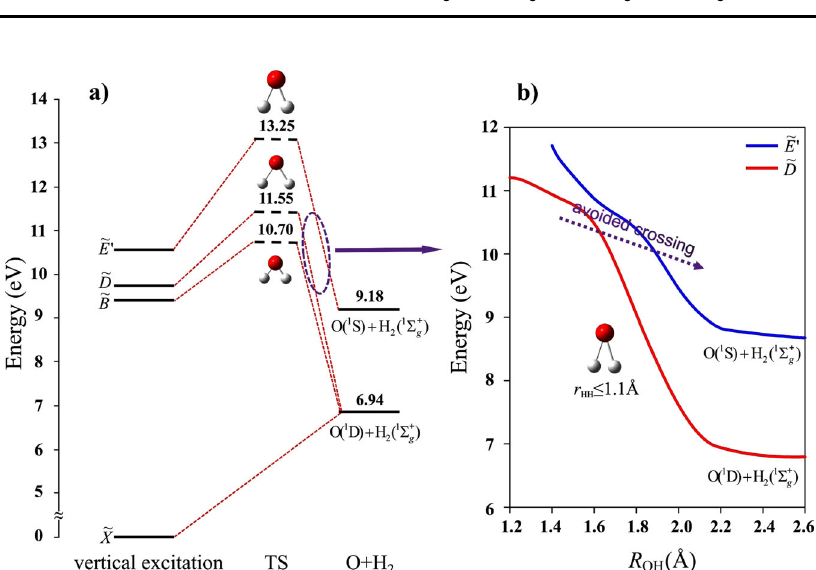
Fig. 5 Schematic diagram of photodissociation mechanisms of H 2 O. a The correlation diagram of O + H 2 fragmentation processes from the H 2 O photodissociation. The zero energy is located at the vibrational state (000) of the ground electronic state. The zero-point energy is considered. b The diagram of the nonadiabatic dissociation pathway from ~ D to ~ E 0 state through the avoid crossing on the potential energy surfaces (PESs). The purple dotted arrow indicates the region of the avoid crossing on the PESs.